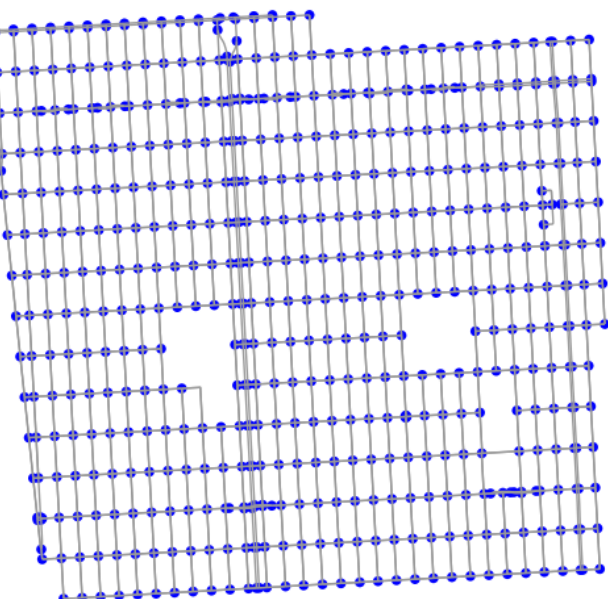
Figure 4. The urban environment used in these experiments. The data were retrieved from the OSMnx python library [36]. Nodes are highlighted in